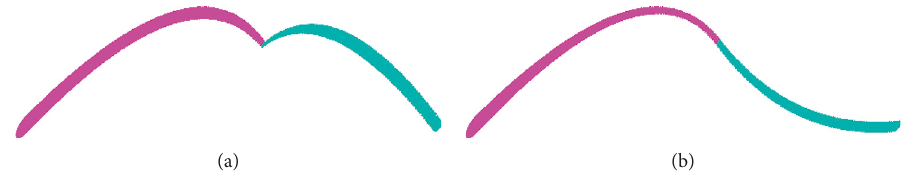
Figure 2: Two BBCs reaching C r ( r � 0, 1) connection. (a) C 0 connection. (b) C 1